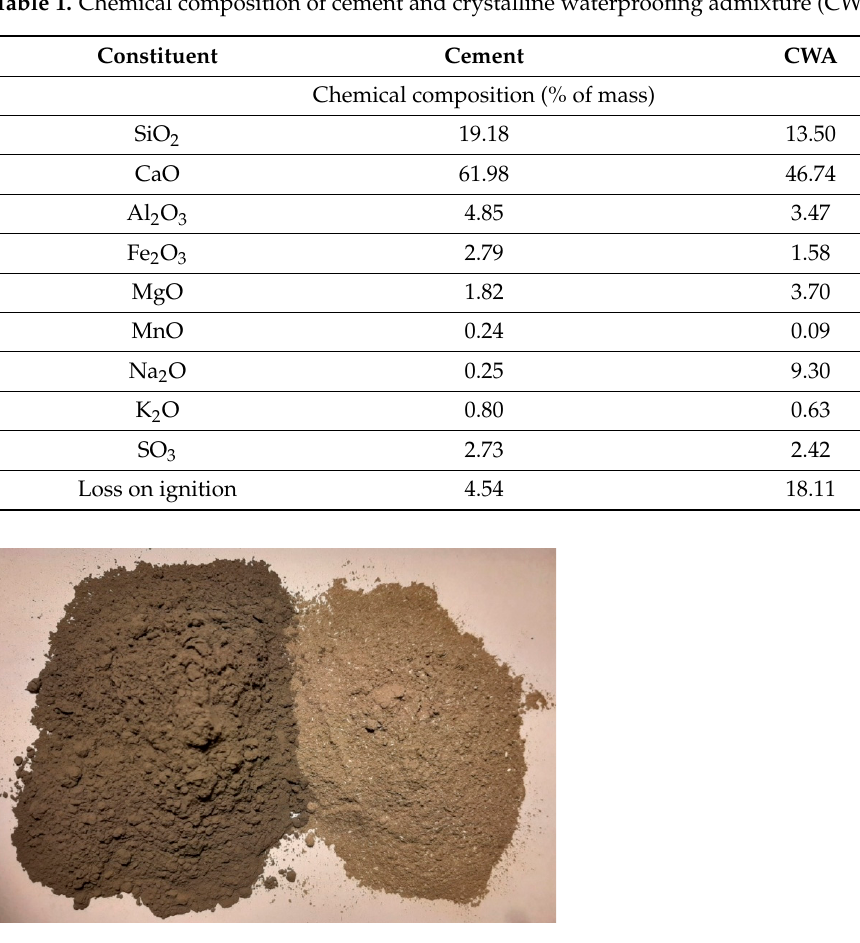
Figure 1. The appearance of cement (left) and CWA (right).